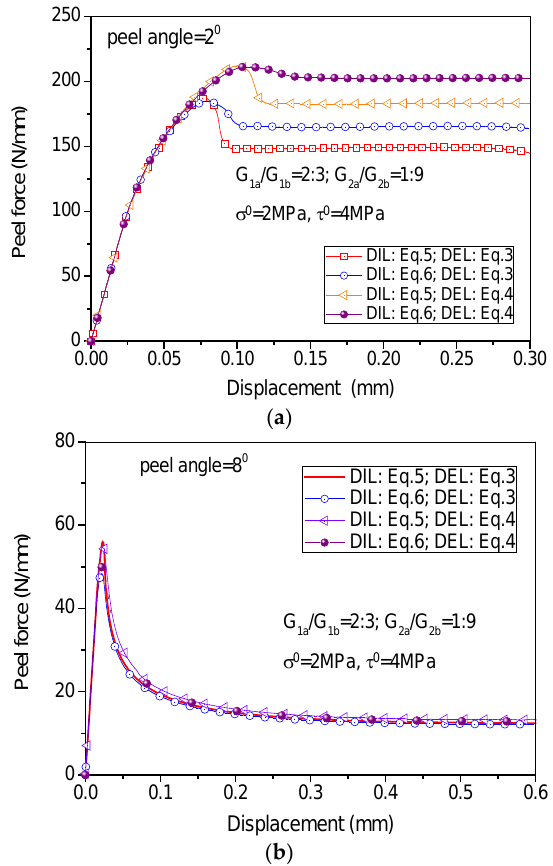
Figure 13. Effect of damage initiation and evolution laws on the load-displacement behavior: ( a ) peel angle = 2 degree; ( b ) peel angle = 8 degree.